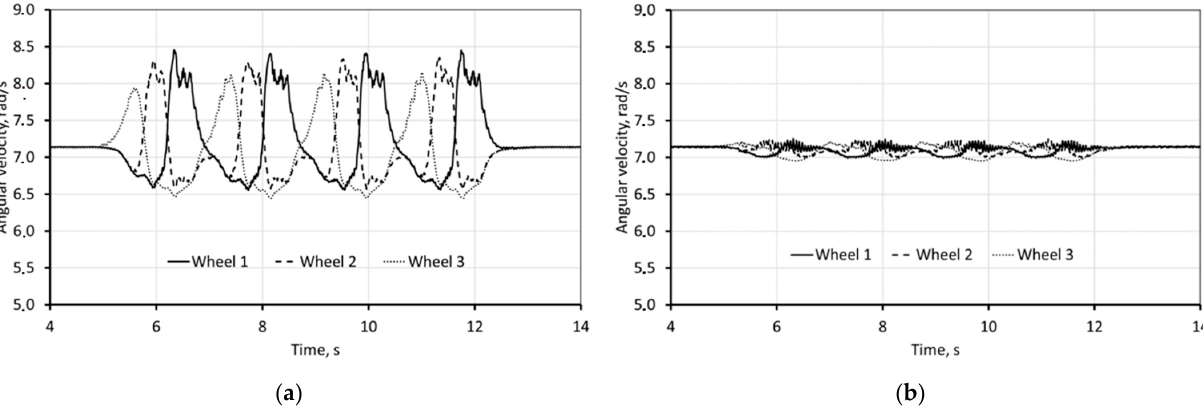
Figure 14. Angular wheel velocity with nominal pump flow for model with spool flow divider ( a ) and for model with gear flow divider ( b ).